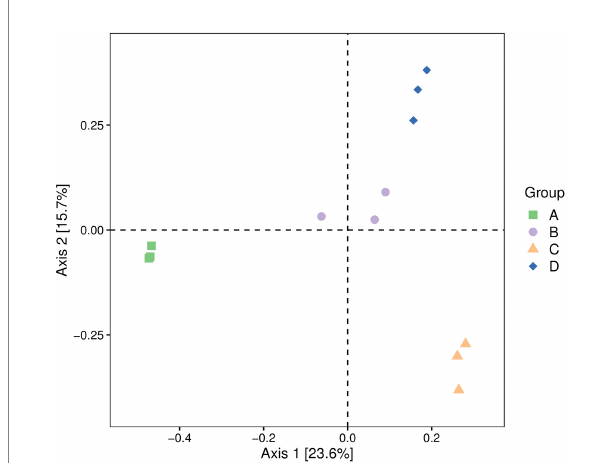
FIGURE 1 PCoA of fungal communities in Yuluxiang pears after storage at low temperatures for 30 d(A), 60 d(B), 90 d(C), and 120 d(D). Each point represents a sample, and the dots of different colors indicate different samples (groups). The percentages in the parentheses on the axis represent the proportion of sample difference data (distance matrix) that can be interpreted by the corresponding axis. PCoA, Principal coordinates analysis.